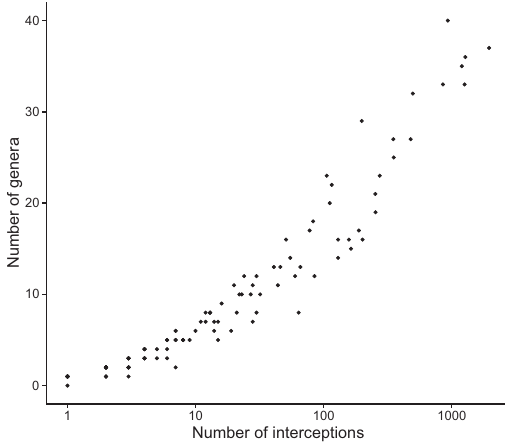
Figure 3. The number of genera observed within ant interceptions from a country of origin, correlated with the number of interceptions detected from that country (n = 209, correlation coefficient 0.80).